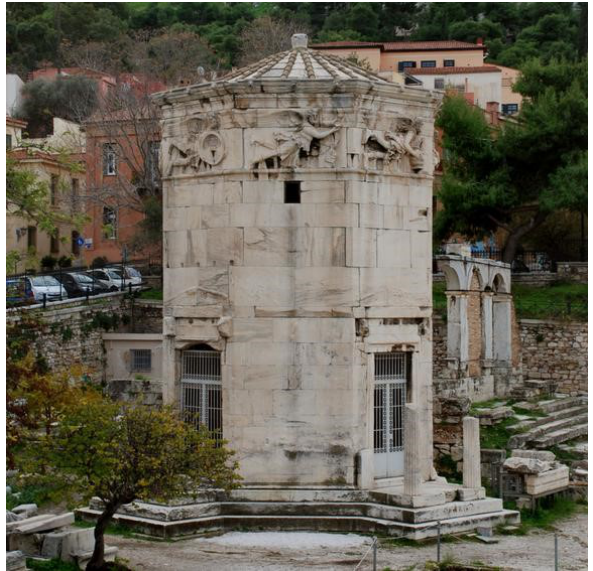
Figure 3: Image of the Tower of the Winds in the 21 st